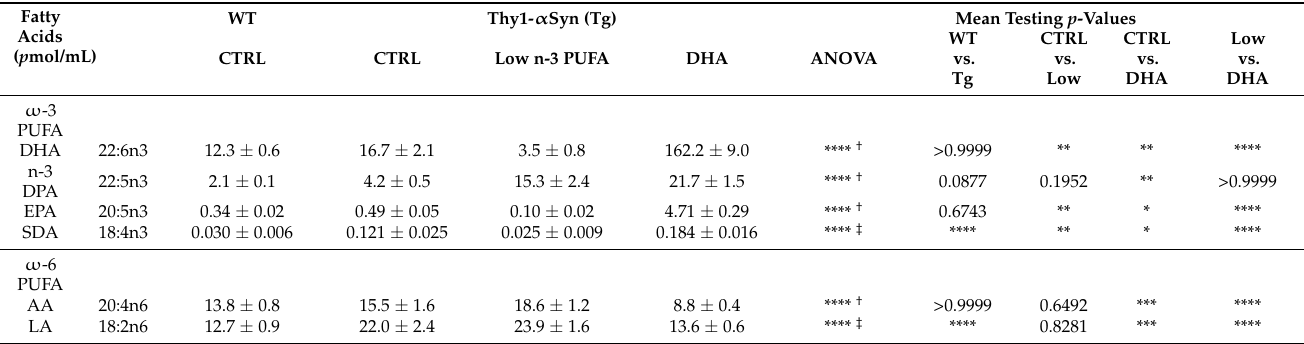
Table 1. Plasma fatty acid composition in WT and Thy1- α Syn